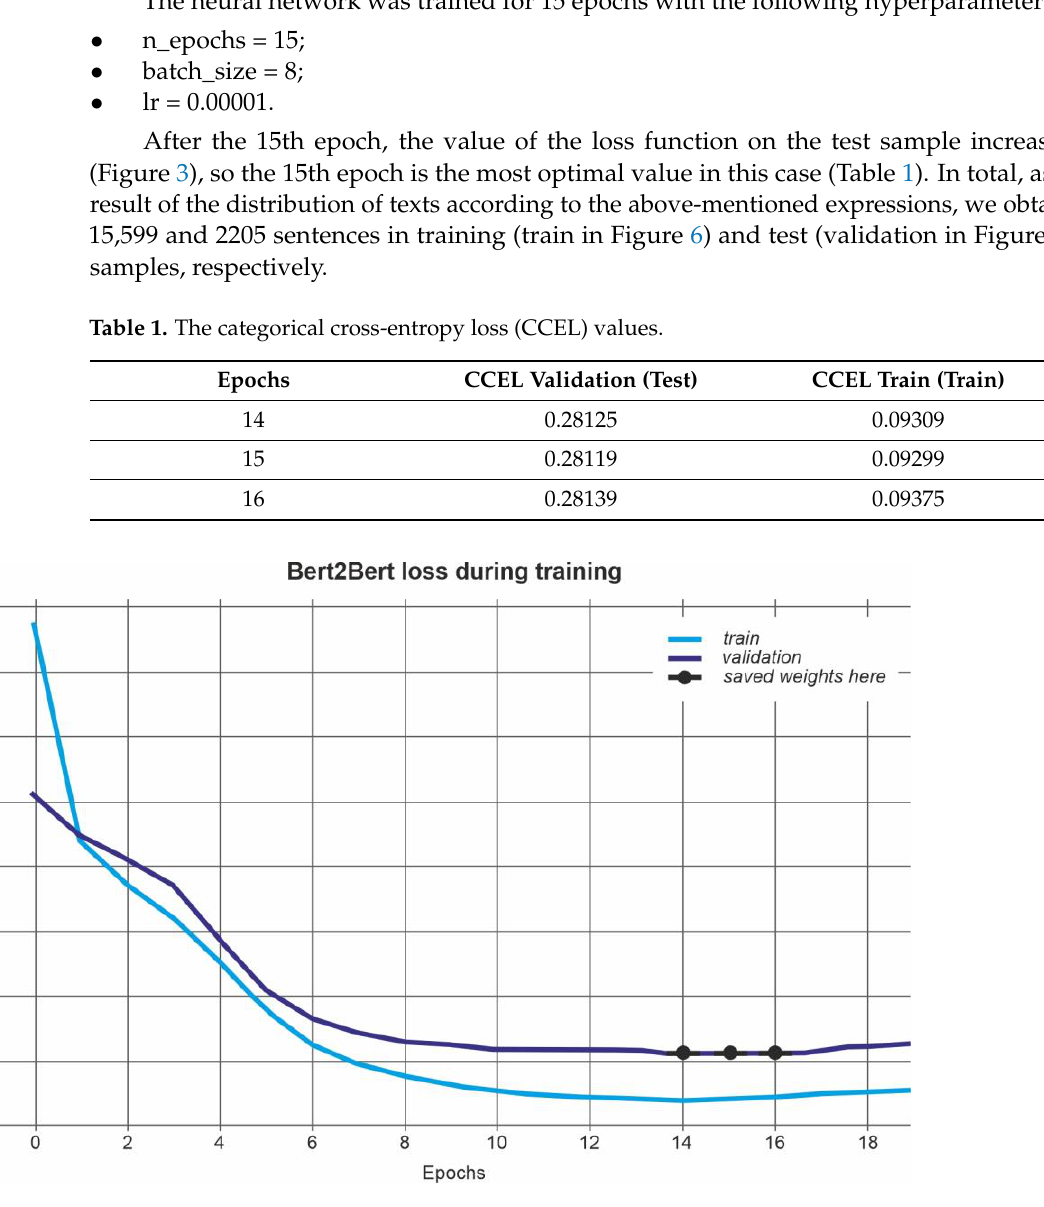
Figure 6. The curve of the loss function during neural network learning. Table 1. The categorical cross-entropy loss (CCEL)